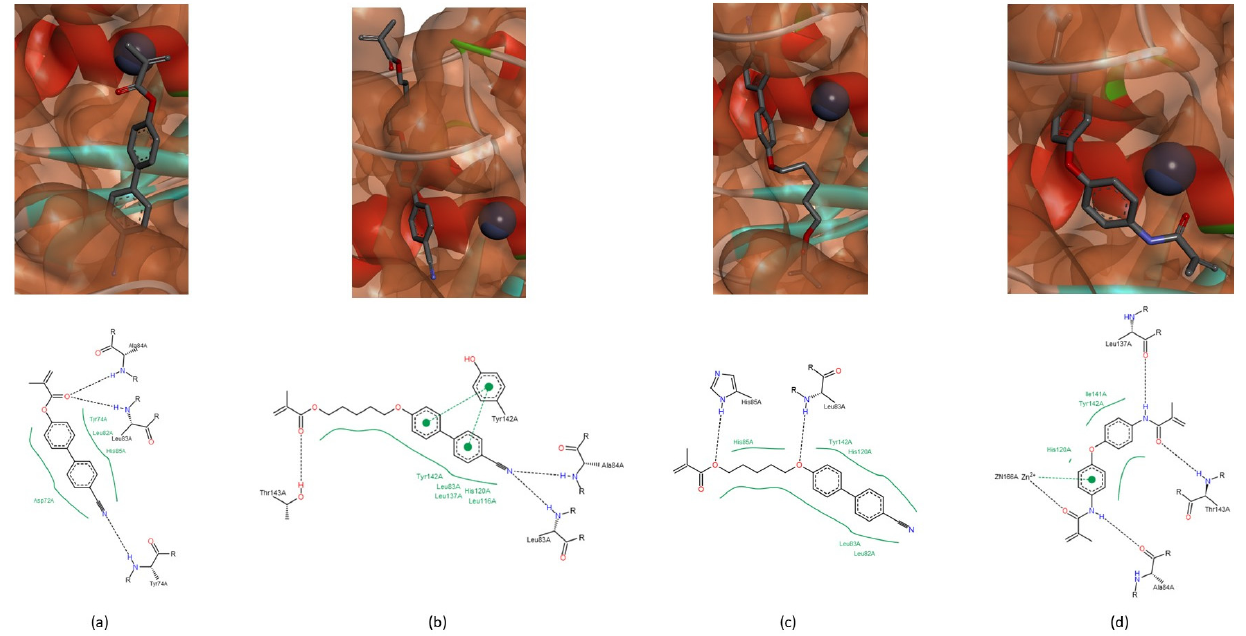
Figure 5. Interactions between compounds A, B and C and the MMP-2. ( a ) Compound A. The oxygen atom of the carbonyl group of methacrylate establishes hydrogen bonds with Leu 83 and Ala 84 , simultaneously. ( b ) Compound B. The CN group establishes hydrogen bonds with Leu 83 and Ala 84 , simultaneously. The residue Tyr 142 interacts with the oxygen atom of the carbonyl group of methacrylate and the residue Thr 143 interacts with the biphenyl group. ( c ) Compound B. The Leu 83 and His 85 establish a hydrogen bond with the oxygen atom of the methacrylate group and with the oxygen atom adjacent to the biphenyl group. ( d ) Compound C. The Ala 84 , Leu 137 and Thr 143 establish a hydrogen bond with the methylacrylamide group.